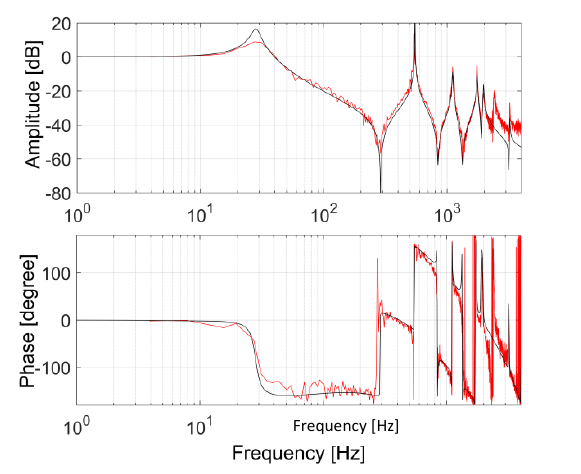
Fig. 9. Comparison of experimental data with simulation results ( simulation results, experimantal